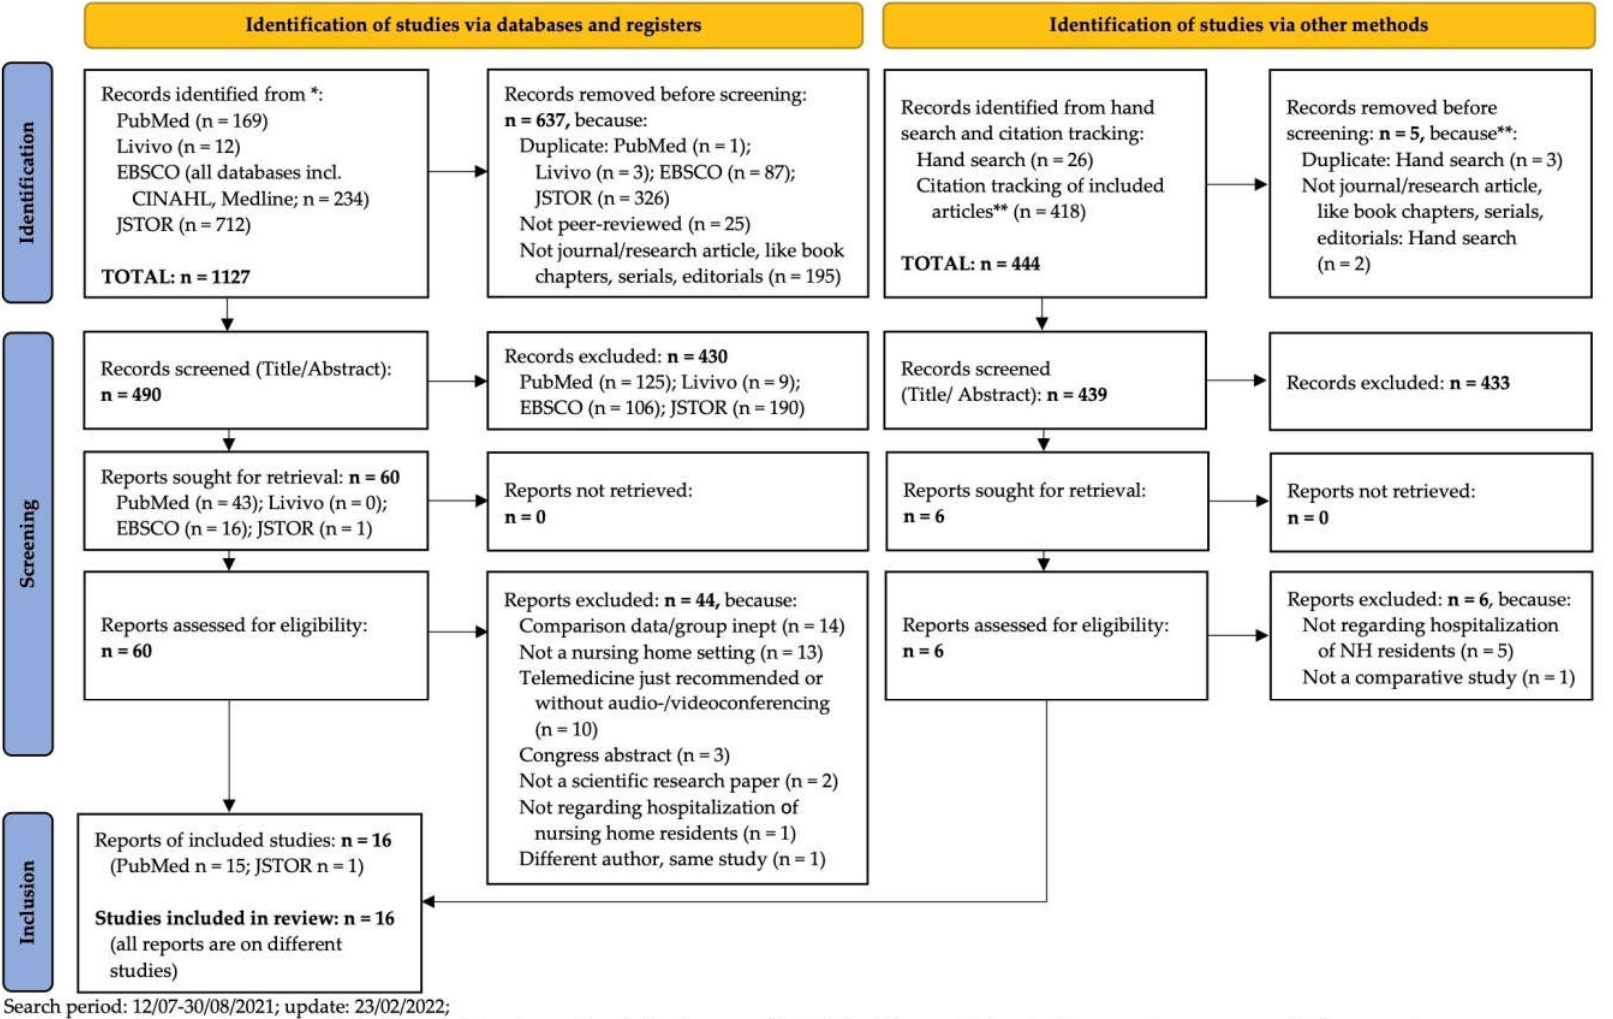
Figure 1. PRISMA flow diagram [67].